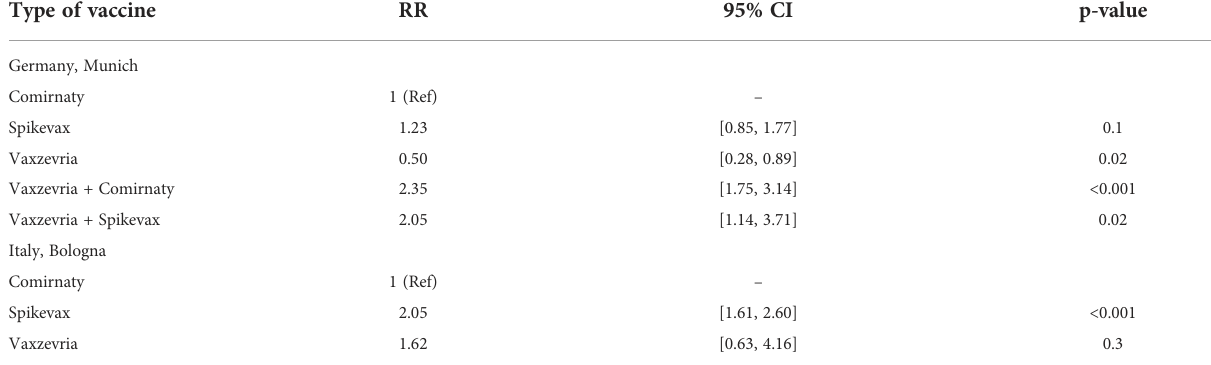
TABLE 4 Relative risk for type of